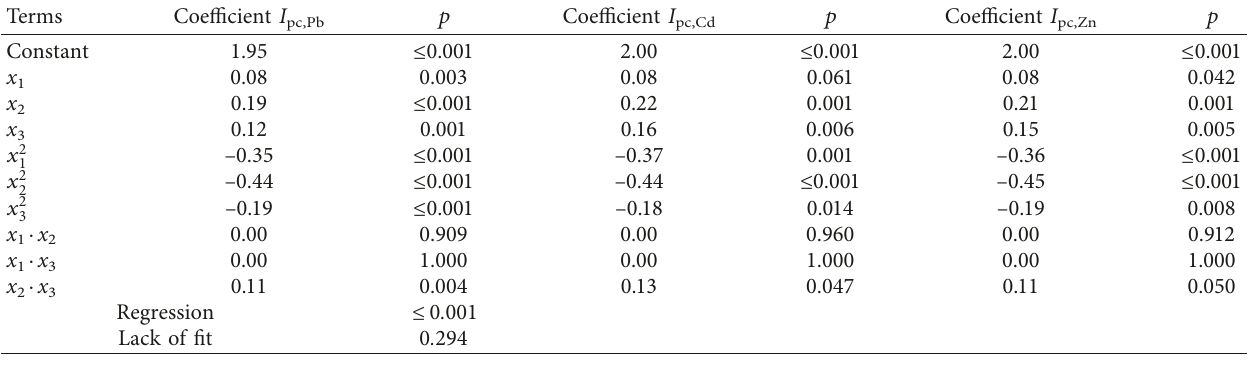
Table 3: Analysis of variance (ANOVA) for B-B design.